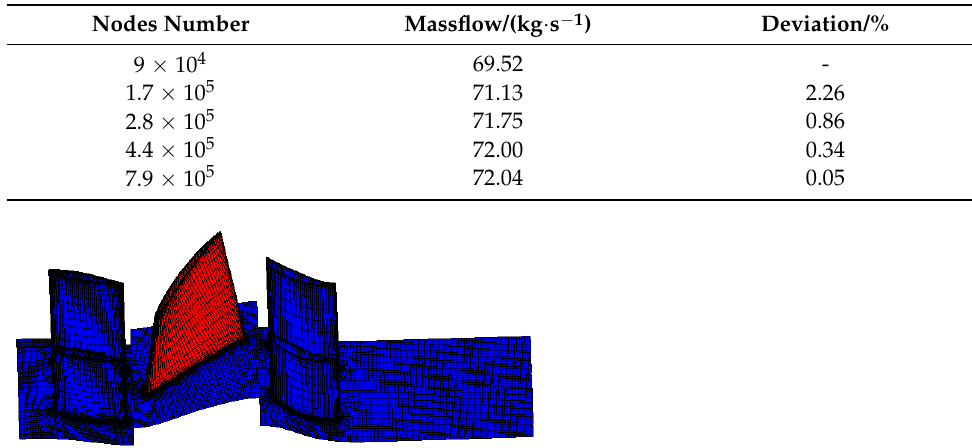
Table 1. Mesh independence study.